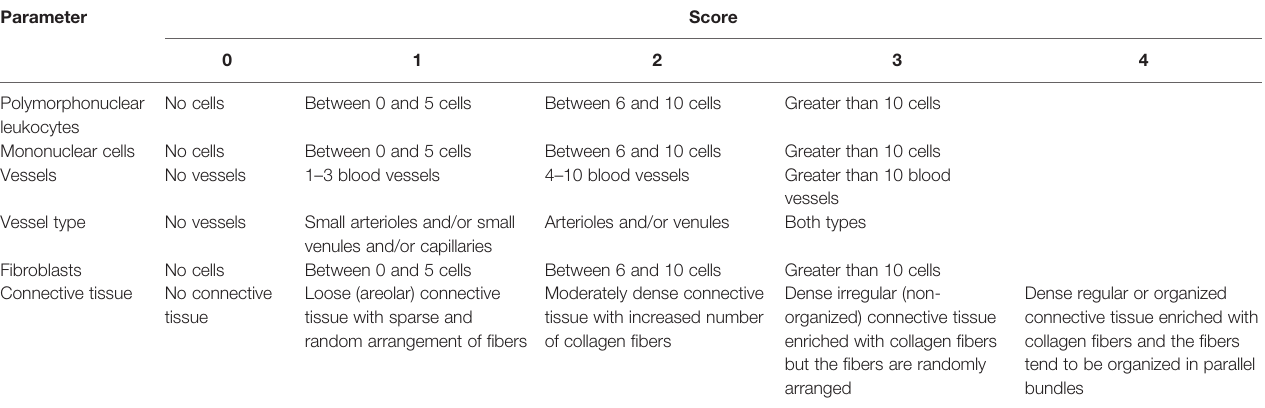
TABLE 2 | Scoring system for histological evaluation of the tissue surrounding and in fi ltrating the surgical meshes 1 week and 1 month after implantation. Parameter